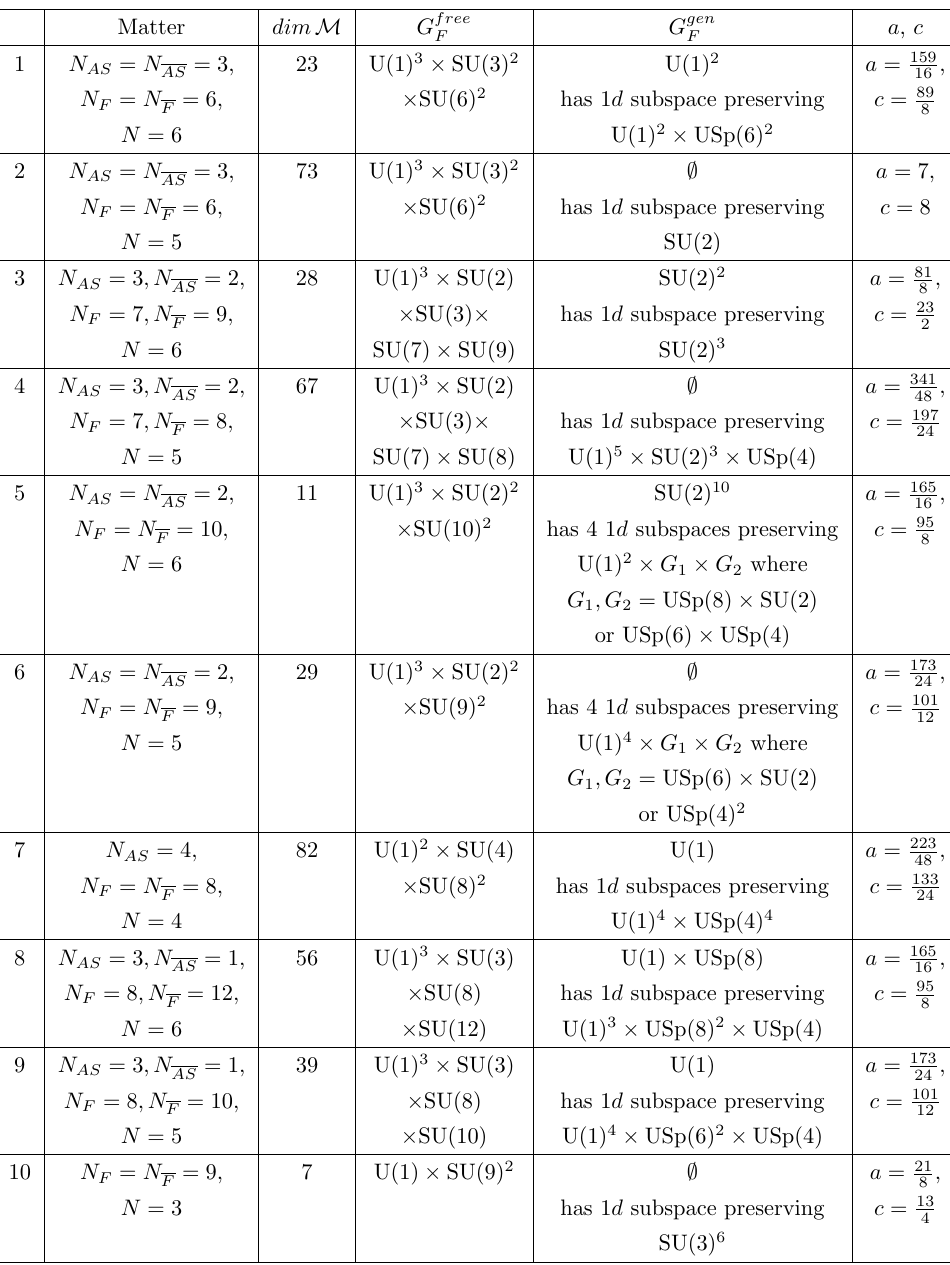
Table 6 . Cases involving an SU( N ) gauge group with fundamental and antisymmetric chiral (cid:12)elds